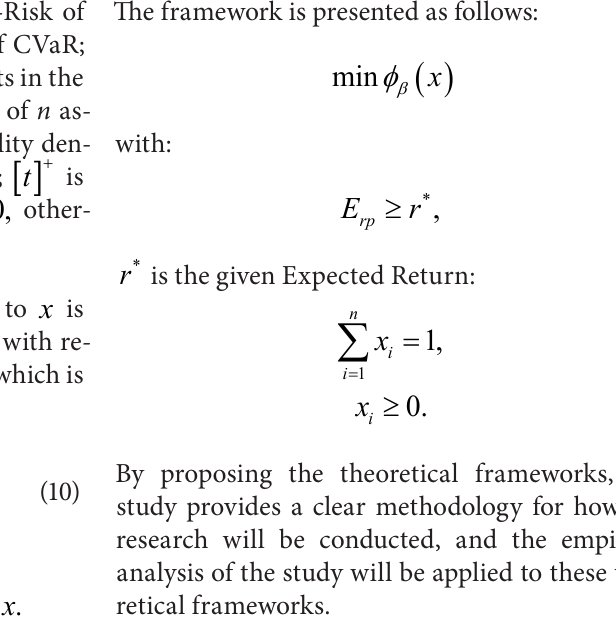
Table 1. Mean returns and 95% CVaR of 10 portfolios in each case Mean-CVaR under Gaussian copula simulation Portfolio number